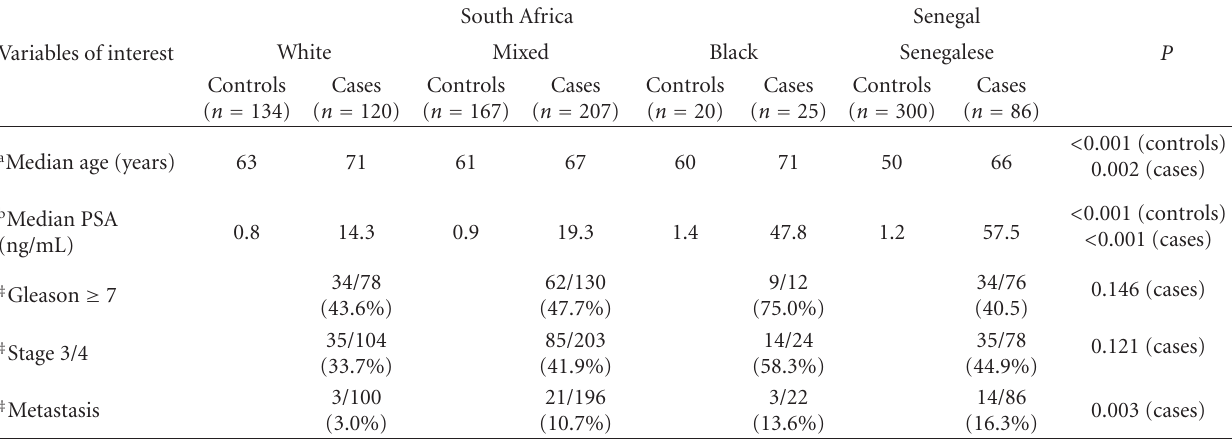
Table 1: Description of clinical characteristics among South African and Senegalese prostate cancer cases and controls. South Africa